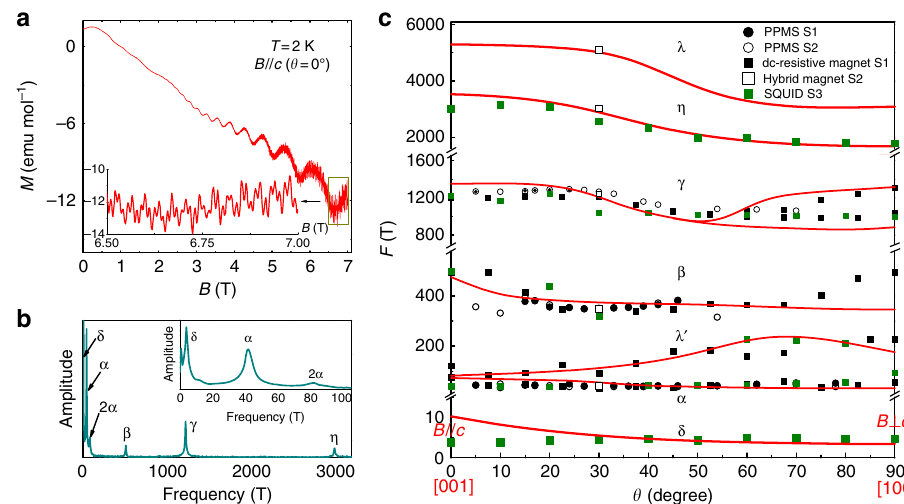
Fig. 4 Magnetization oscillations and angle-dependent oscillation frequencies. a Magnetization curve measured at T = 2 K on sample S3 with magnetic fi eld applied along the c -axis. b FFT spectra of dHvA oscillations. Inset: enlargement of FFT spectra. c Angle dependences of the frequencies extracted from the SdH and dHvA oscillations of different samples are labeled with different symbols. Theoretical calculated results are plotted with solid red